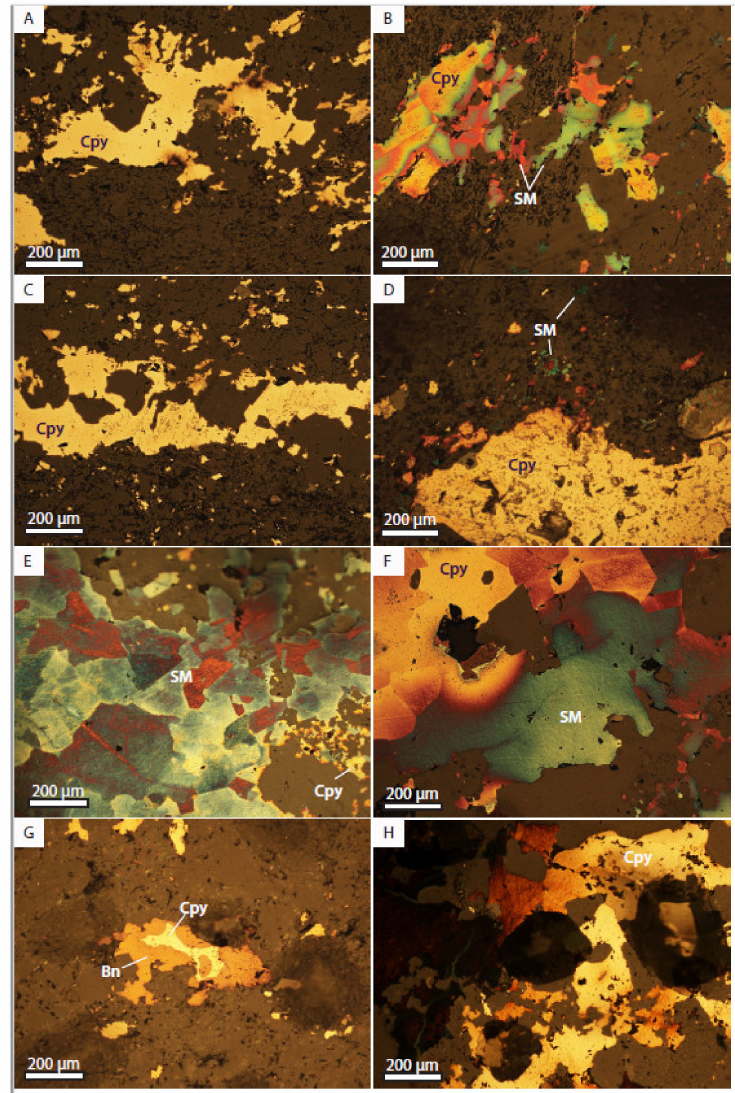
Figure 4. Microphotographs of samples under the reflected light microscope from the Nussir test runs after 90 days of the weathering experiment. The photographs are taken in crossed polars and correspond to test setups from 1 to 8 in Table 1. ( A ) reductive condition #1: well-preserved chalcopyrite (Cpy) grain (sample ENV-NS-1); ( B ) reductive condition #2: secondary minerals (SM) on top of chalcopyrite (Cpy) (sample ENV-NS-2d); ( C ) reductive condition #3: well-preserved chalcopyrite, secondary minerals are possibly forming in the cavities in the grain (Sample ENV- NS-3); ( D ) reductive condition #4: secondary minerals formed on the surface of chalcopyrite (Cpy, sample ENV-NS-4); ( E ) oxidative condition: secondary minerals on the surface of Cpy (ENV-NS-5); ( F ) oxidative condition #6: Cpy grain is partly oxidized (ENV-NS-6); ( G ) oxidative condition #7: well- preserved assemblage of Cpy and bornite (Bn) (ENV-NS-7); ( H ) oxidative condition #8: intensively oxidized chalcopyrite grain